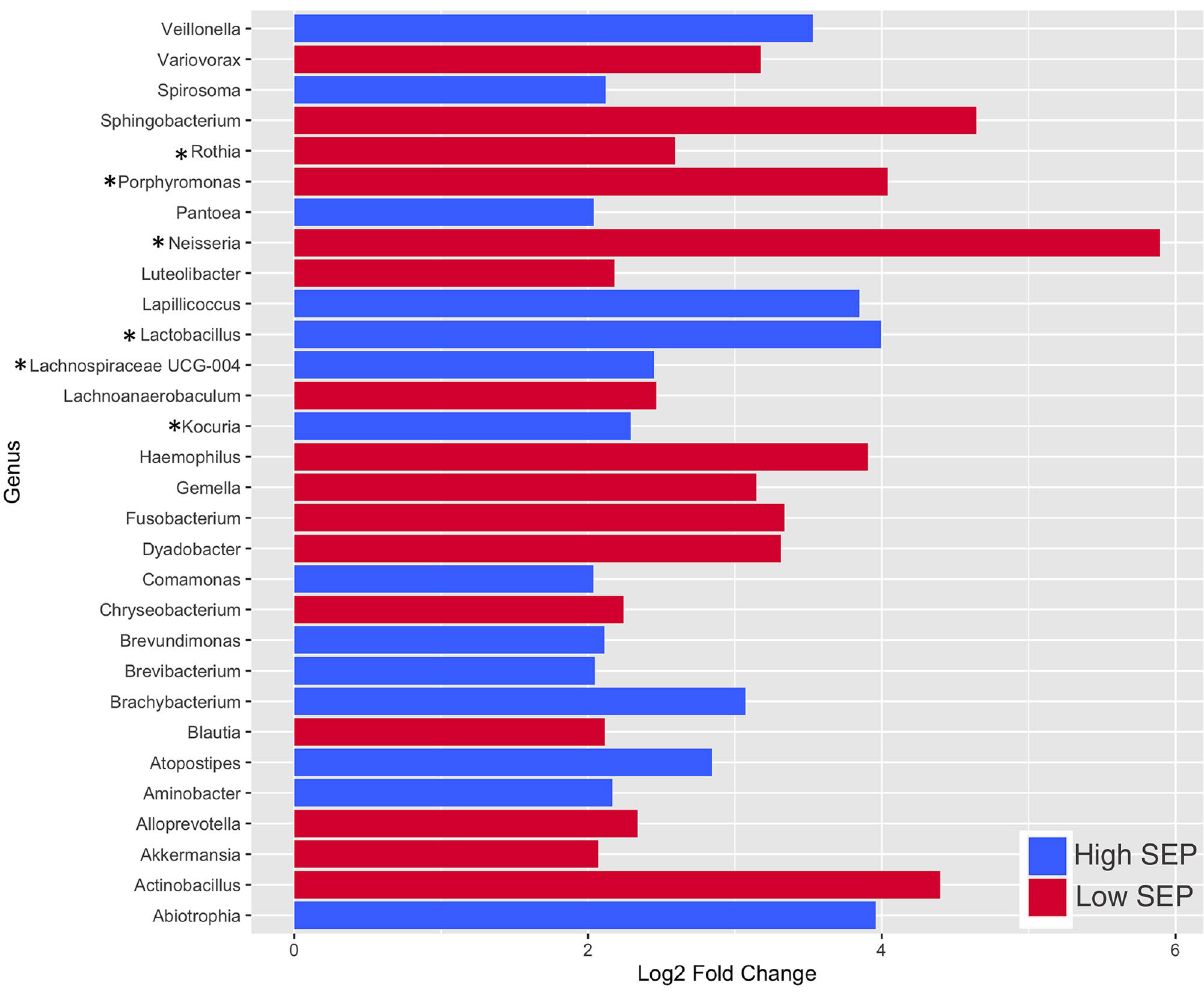
Figure 3. Differentiated Taxa Analysis showing Log2 changes in discriminant genera between the High and Low SEP groups, where * represents genera identified as being of particular interest. All discriminant genera shown have an adjusted p value <